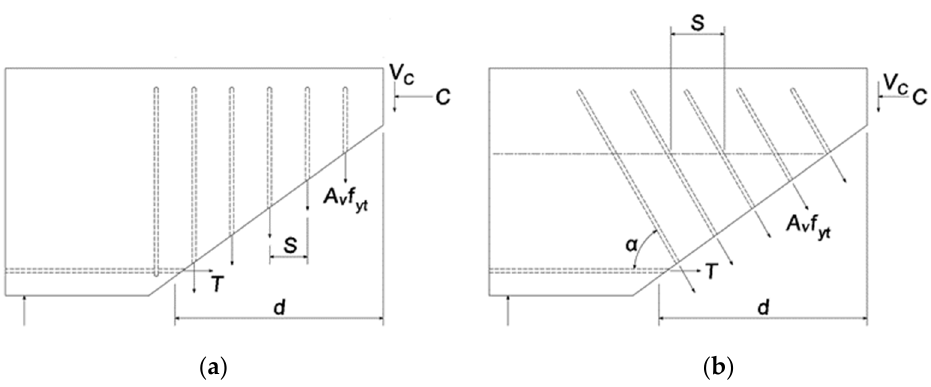
Figure 10. Shear resistance with stirrups. ( a ) Vertical stirrups. ( b ) Inclined stirrups.